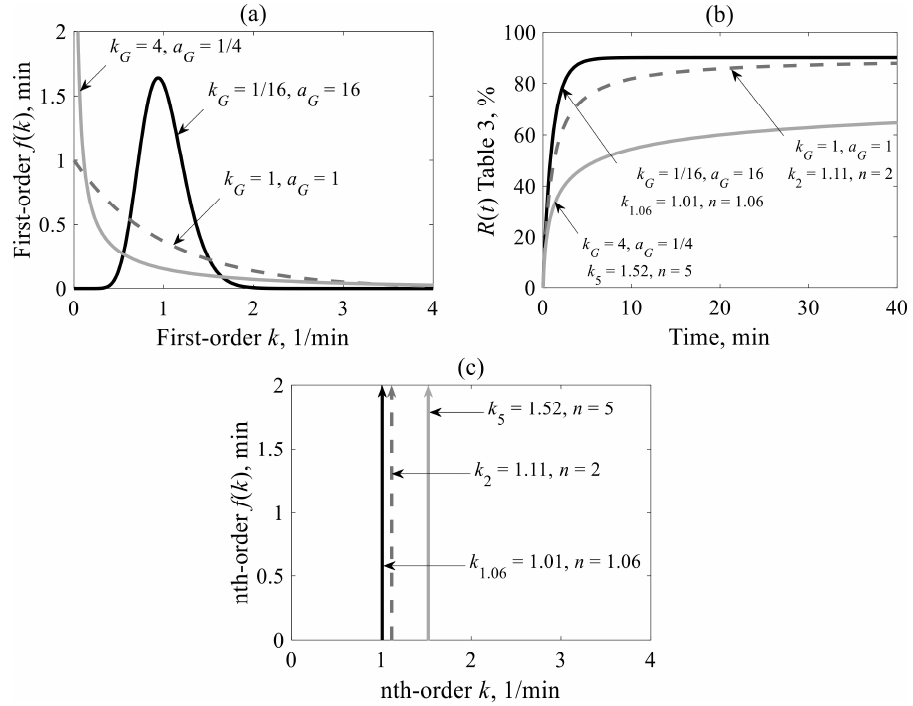
Figure 1. ( a ) Different first-order Gamma f ( k )s with the same average rate constant, ( b ) Time-recovery curves, Table 3, ( c ) nth-order f ( k )s.